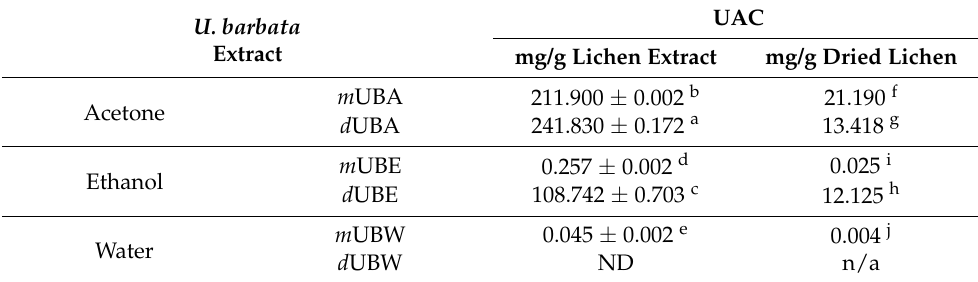
Table 2. Usnic acid content in fluid and dry U. barbata extracts.